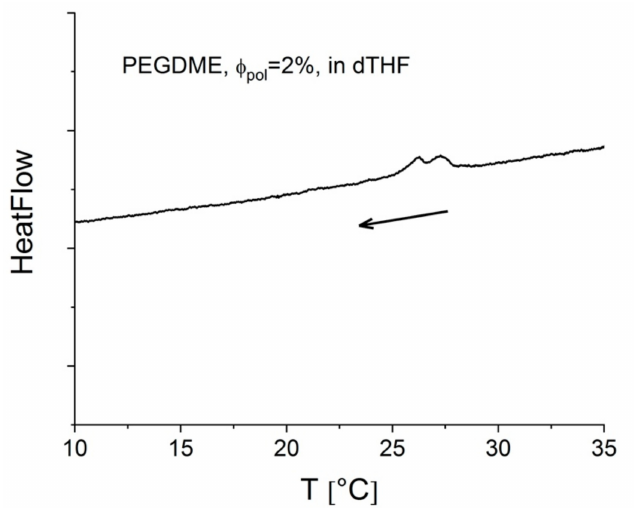
Figure 4. The thermal behavior of hPEGDME (M W = 20,000 g mol − 1 ) in solution of dTHF ( φ pol = 2%) during the crystallization process at a rate of 5 ◦